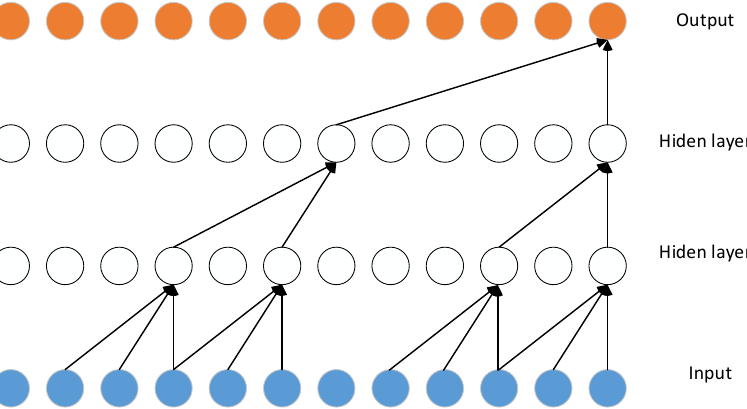
Figure 2. The schematic diagram of dilated convolution.